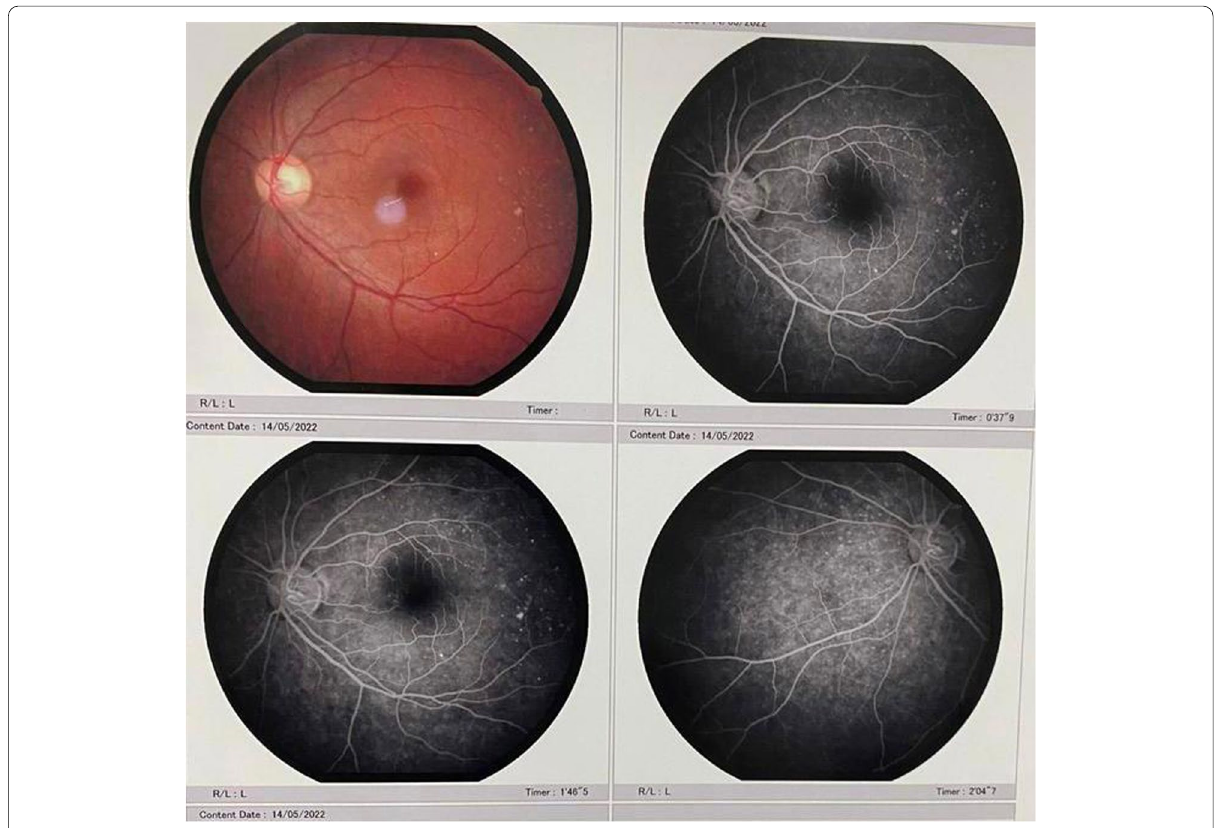
Fig. 6 Fundus fluorescein angiography of the left